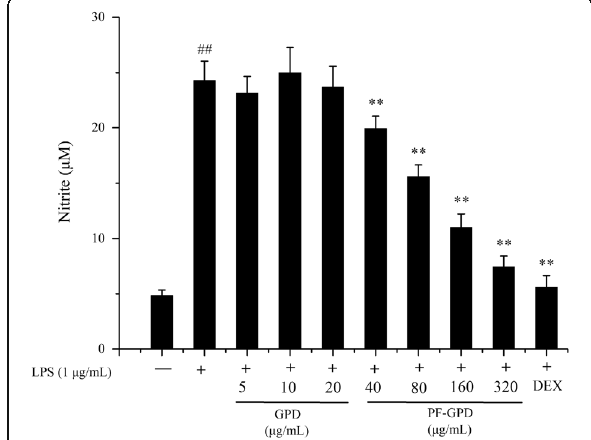
Fig. 3 Effects of GPD and PF-GPD on inflammatory media PGE 2 and TNF- α and pro-inflammatory cytokines secretion in RAW 264.7 cells. Cells pretreated with indicated concentrations of GPD or PF-GPD for 2 h were stimulated without or with 1 μ g/mL of LPS for 24 h.